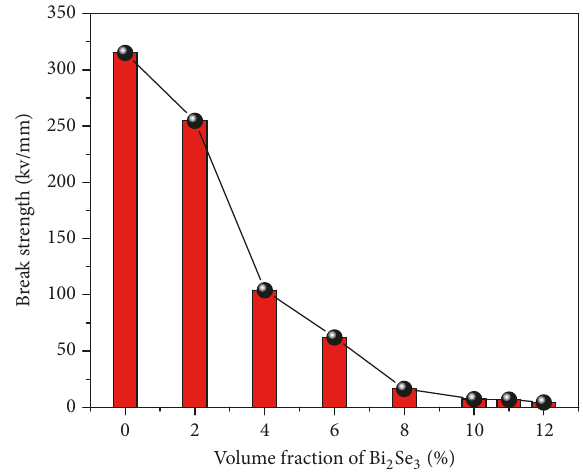
Figure 8: Histogram of breakdown strength as a function of Bi 2 Se 3 volume